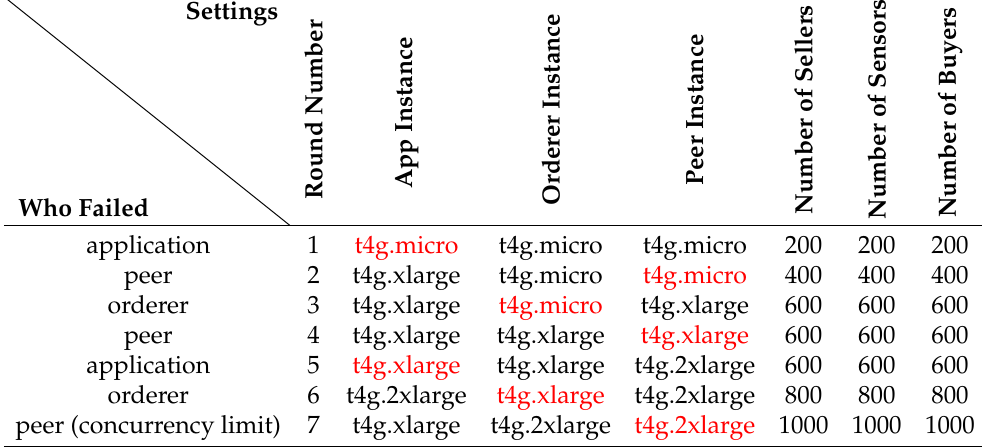
Table 2. Configurations that lead to failure in Phase 1. The instances which indicated failure are highlighted in